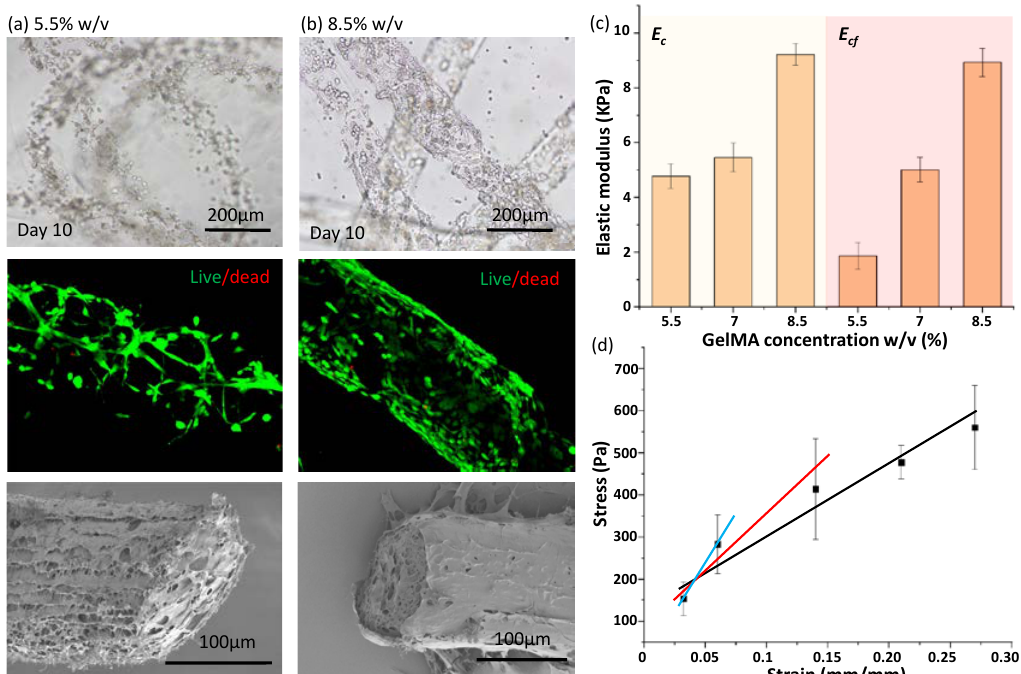
Figure 6. Reasonableness verification of E measurement. ( a , b ) Cell growth in 5.5% and 8.5% w / v GelMA microfibers, respectively. (Images of bright field, fluorescence for indicating live/dead cell, SEM for showing porous structure from top to bottom). ( c ) E c for cyclic force loading vs. E cf for constant force loading. ( d ) Stress-strain curves fitted from previous two (blue), three (red) sample data and whole sample data (black).